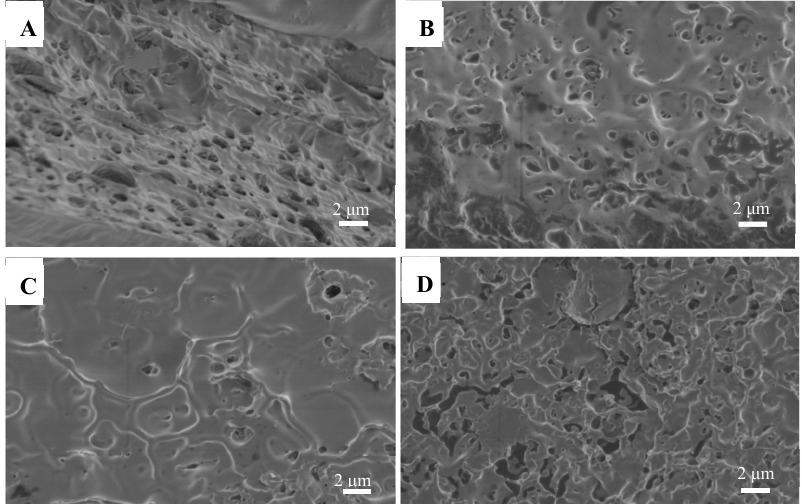
Figure 2. SEM images of the surface of the antimicrobial PLA films with different amounts of β -CD/AITC (( A ) PLA film; ( B – D ) PLA films with 2%, 10%, 20% β -CD/AITC, respectively).